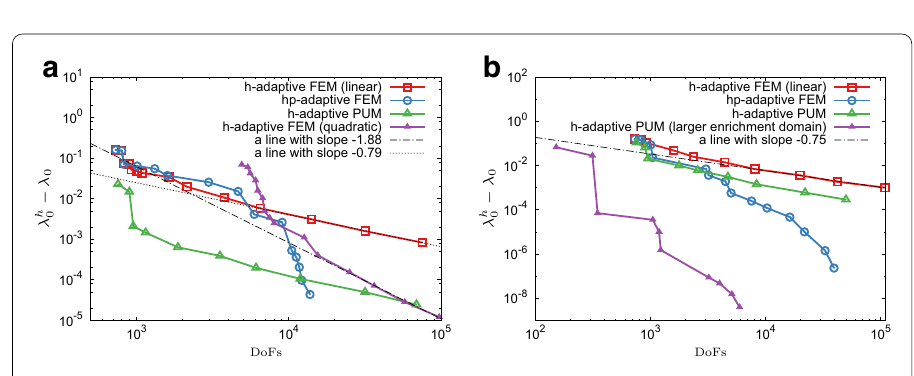
Fig. 2 Error convergence rates for an eigenproblem with a single eigenpair. a Coulomb potential. b Harmonic potential